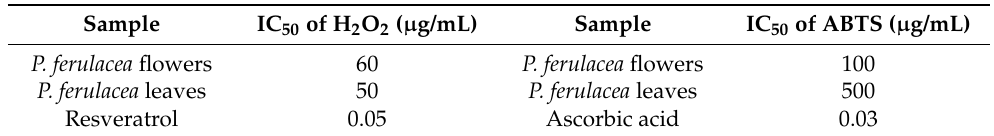
Table 3. IC 50 : concentration that inhibited 50% of the free radicals; ABTS: 2,20-azino-bis